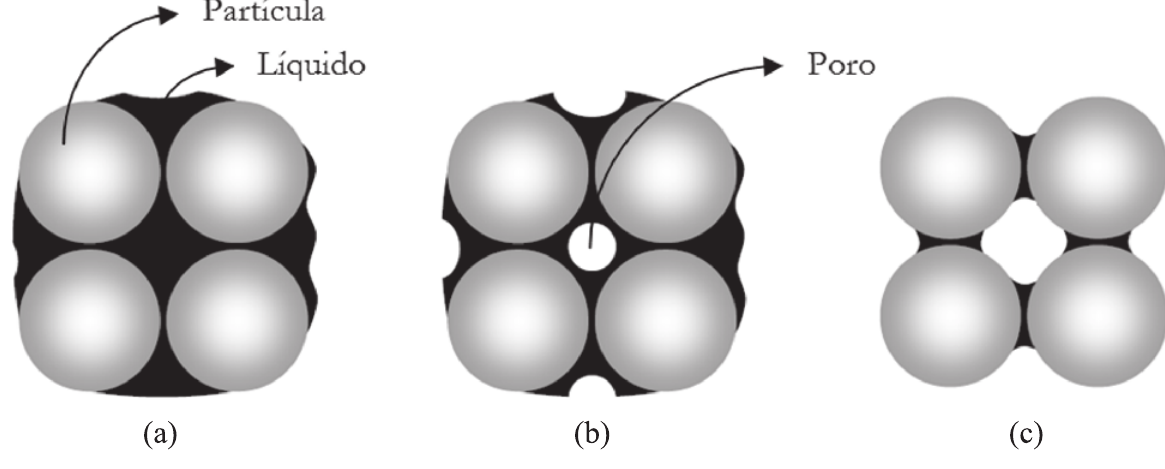
Condições de dispersão de partículas em água [adaptado de